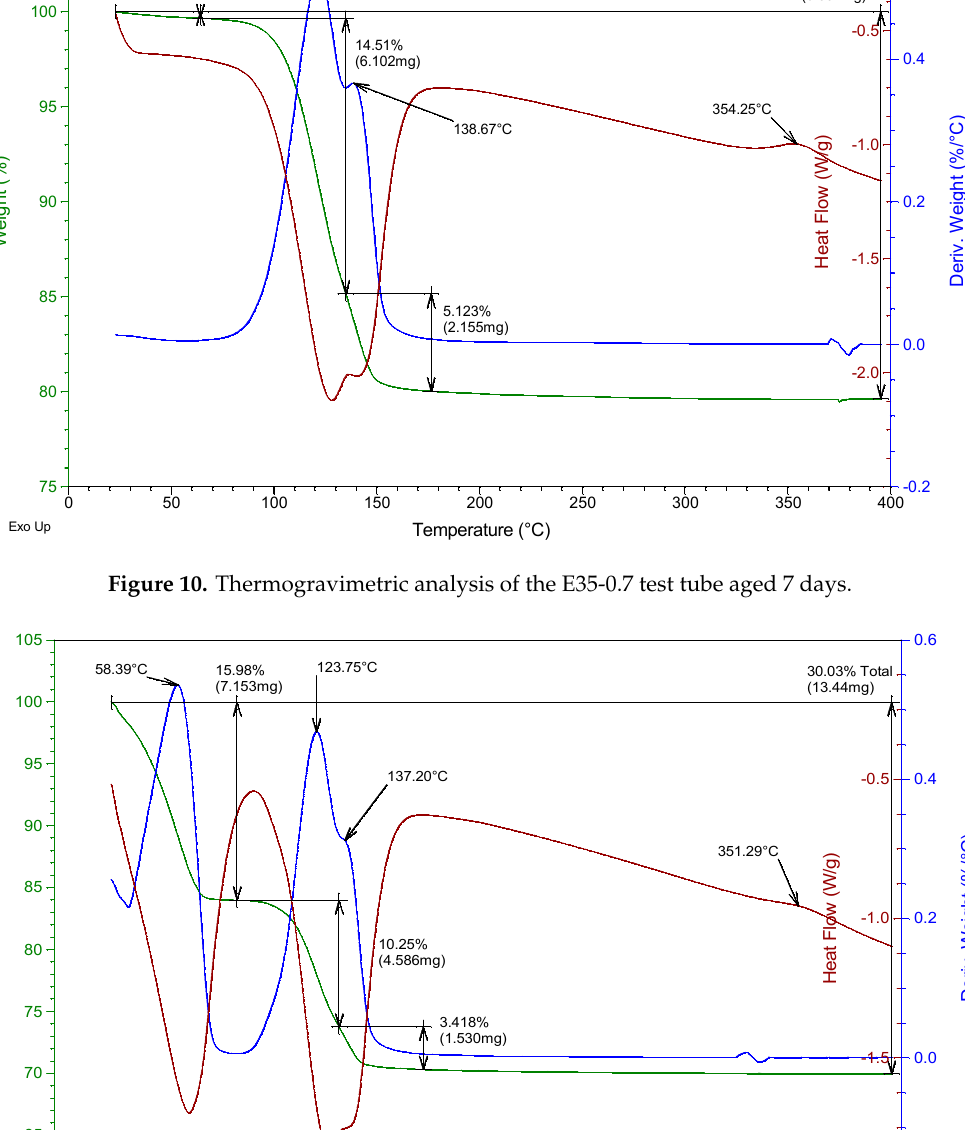
Figure 9. Thermogravimetric analysis of the test tube E35-0.7 aged 1 day.